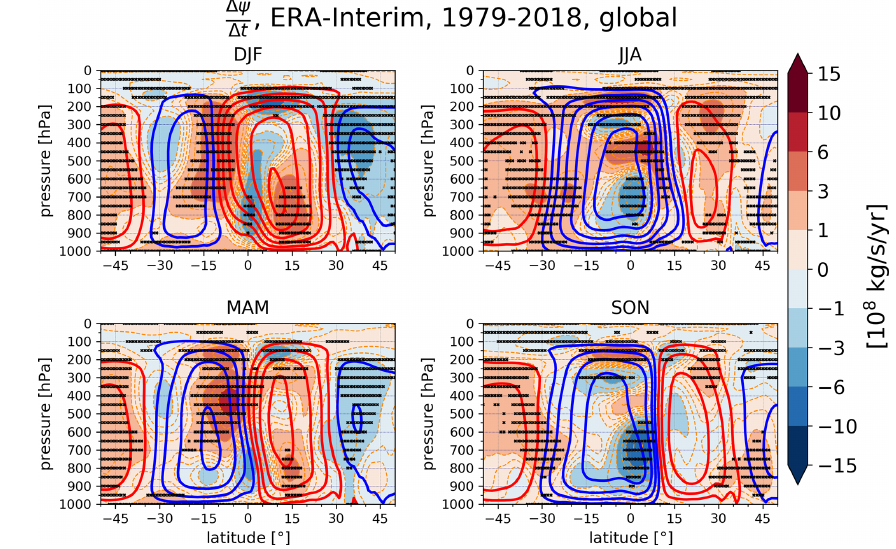
Figure A1. As in Fig. 1, but for the ERA-Interim reanalysis.